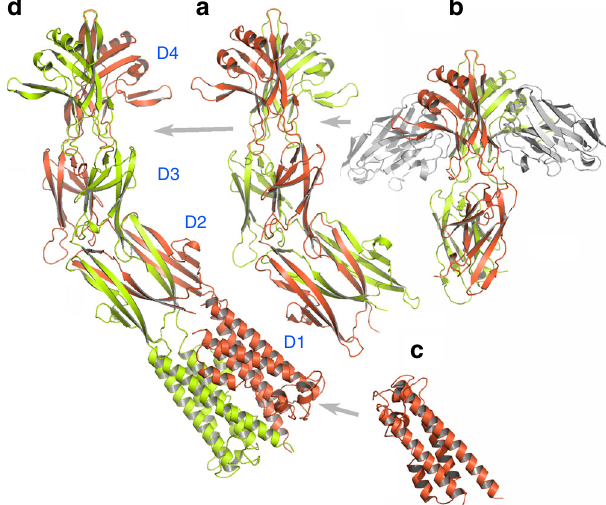
Fig. 2 Crystal structure of PorMp from Porphyromonas gingivalis . a Ribbon view of the PorMp 224 fragment structure (residues 224 – 516) and b of the PorMp 335 fragment structure (residues 224 – 516) in complex with the nanobody nb130 colored by polypeptide chain (yellow and red, gray for nb130). c Ribbon view of the PorMp nt fragment (nanobody not shown). d Ribbon view of a PorMp model obtained by aligning the N-terminal D1 domain and the D2 domain on the GldMp scaffold. The domains are